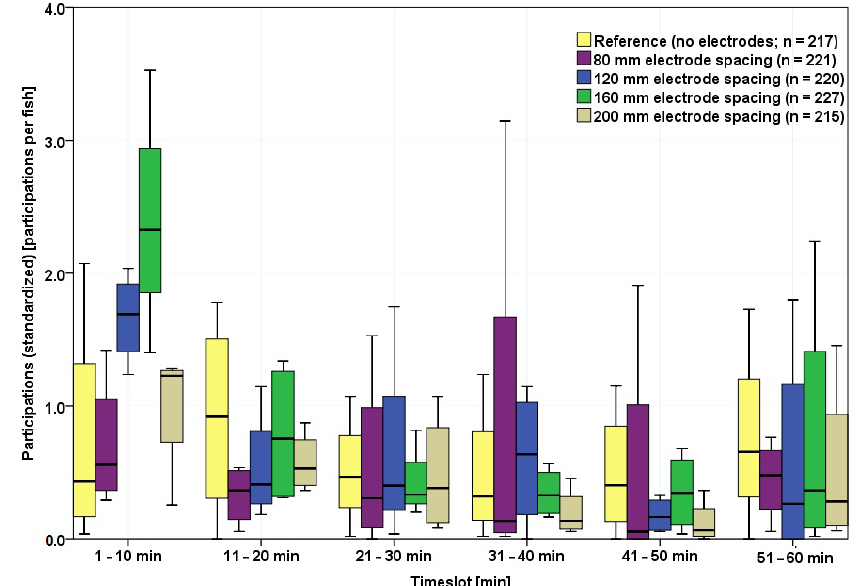
Figure 3. Standardized participations (recorded participations/stocked individuals in experiment) during time slots of 10 min each for all five setups (each N = 4). Boxplots include representative statistic measures: minimum, first quartile, median, third quartile and maximum. Number of participating individuals per setup and four trials (N = 4) is denoted as n.